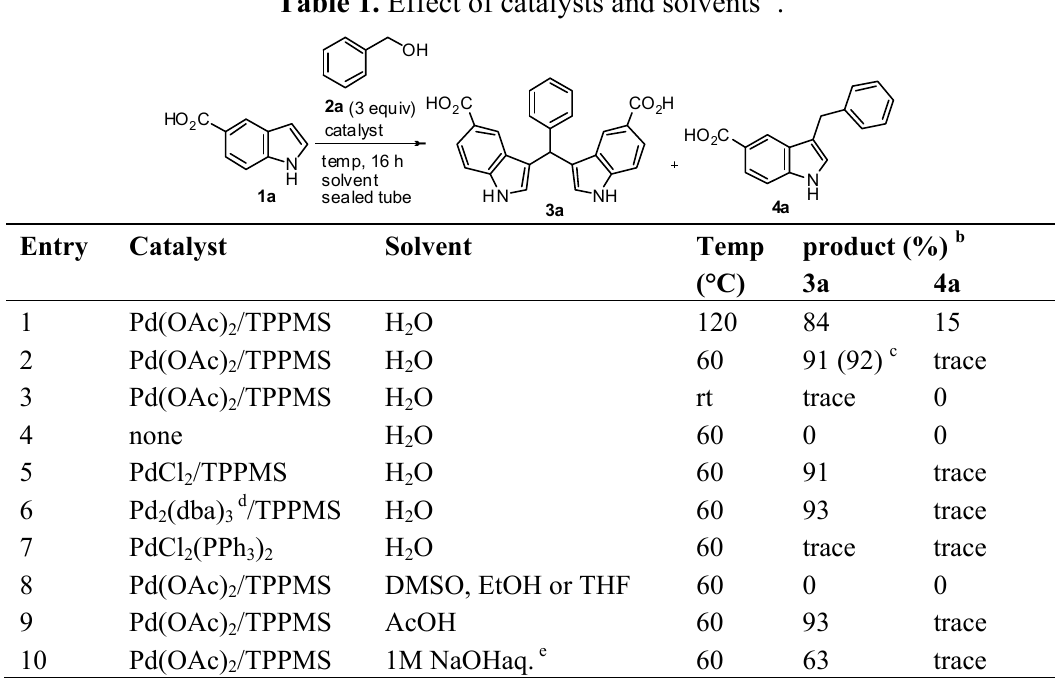
Figure 1. Scope of alcohols 2 and indole carboxylic acids 1 a . a Reaction conditions: 1a (0.5–1 mmol), Pd(OAc) (5 mol%), TPPMS (10 mol%), benzyl alcohols 2 (3 equiv), H 2